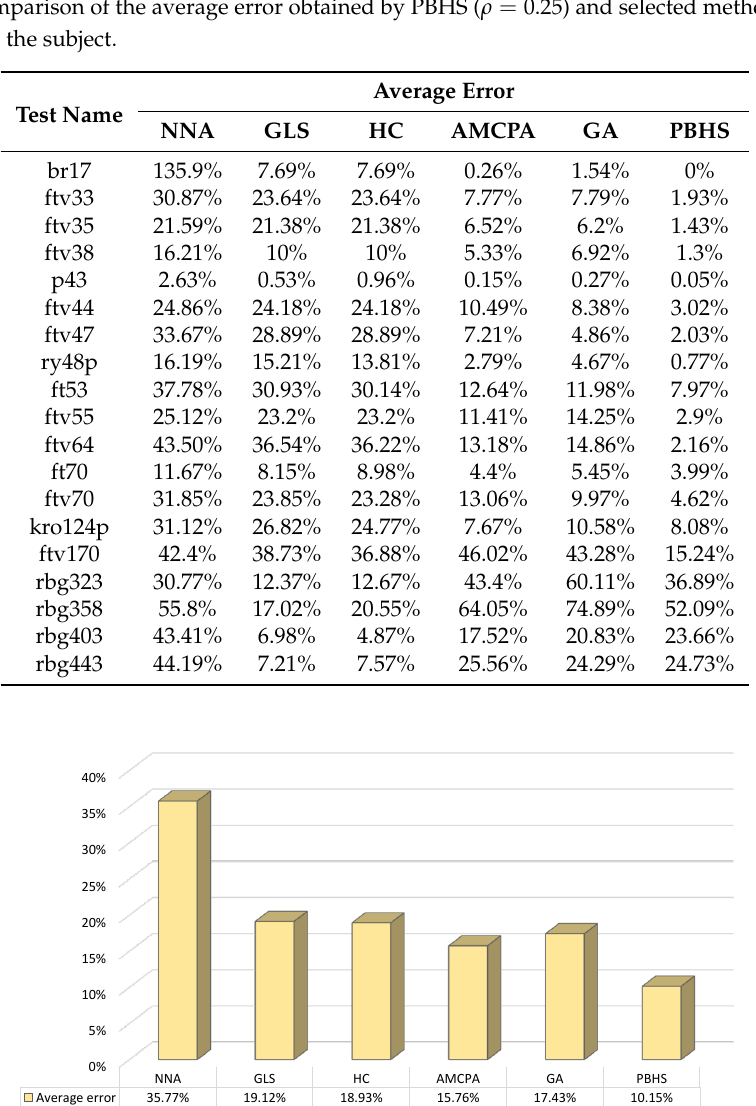
Figure 2. Comparison of the average error obtained by PBHS ( ρ = 0.25) and selected methods from the literature on the